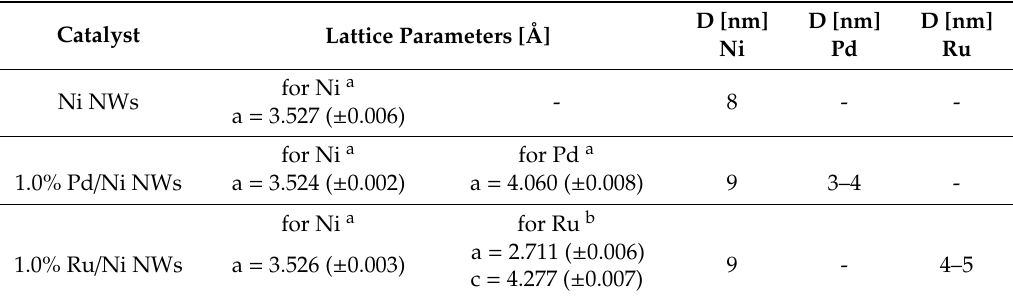
Figure 2. ( A ) The X-ray diffraction patterns of the 1.0% Pd/Ni, 1.0% Ru/Ni, and Ni nanowires (NWs) samples in the 20–130 2 θ range. The Miller indices for the experimental peaks of Ni NWs are marked. ( B , C ) The larger diffraction patterns in the 30–58° 2 θ range. The main peaks of Pd and Ru nanoparticles (NPs) are shown. Table 2. The average crystallite size and lattice parameters of the investigated nanomaterials as determined by the X-ray diffraction technique (XRD) method.